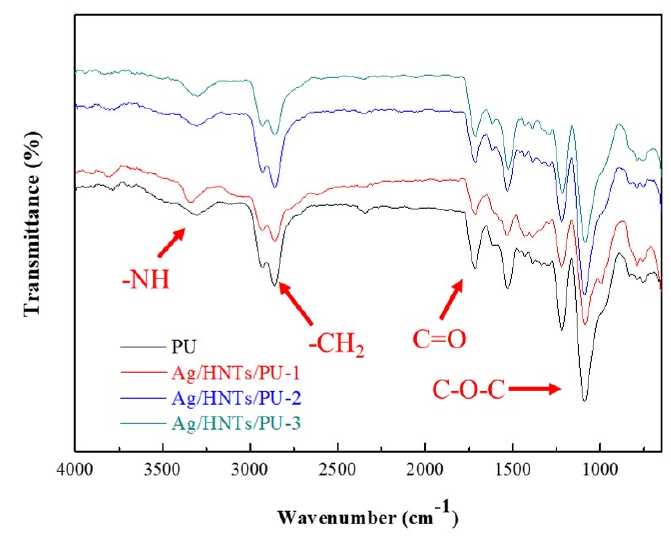
Figure 3. Fourier-transform infrared spectroscopy (FT-IR) spectra of the Ag / HNTs / PUs at the wavenumber range of 4000–650 cm − 1 .